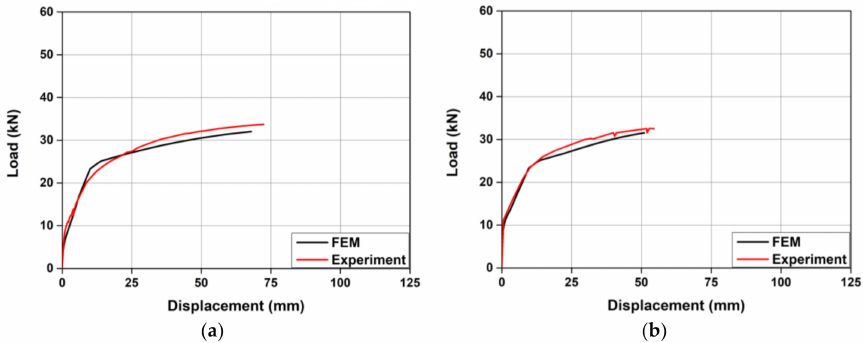
Figure 11. Comparison of load- displacement curves for B2 & B6: ( a ) B2; ( b ) B6.